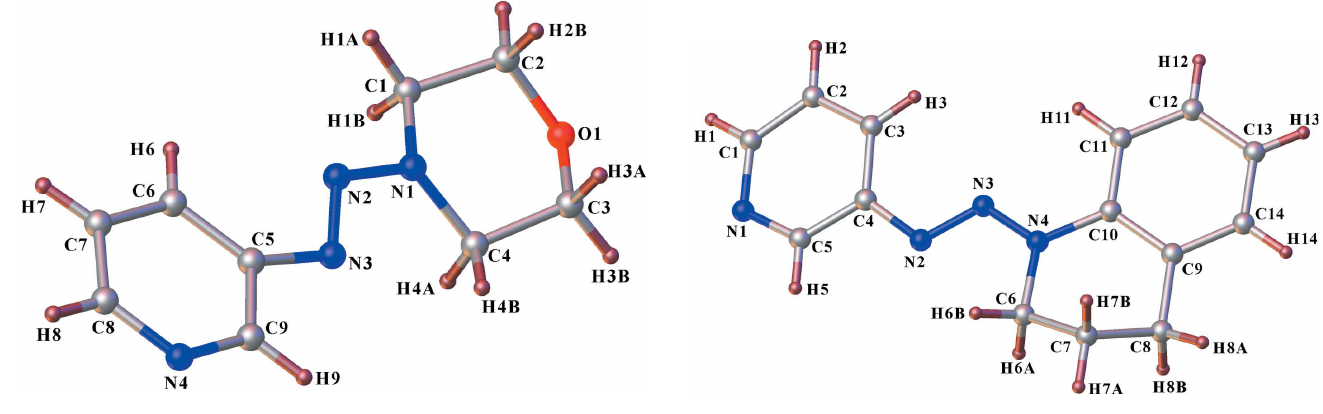
Figure 2 A view of the title compound II , showing the atom-numbering scheme. Displacement ellipsoids are plotted at the 30% probability